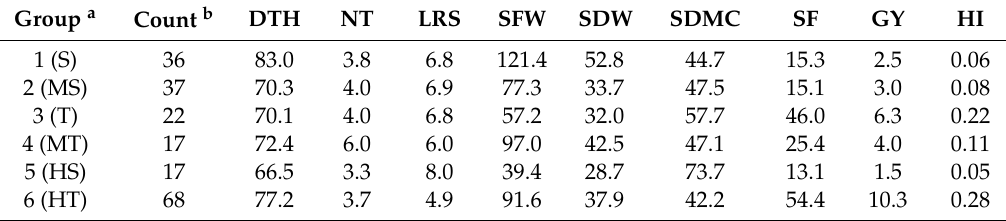
Figure 1. Principal component analysis (PCA) plot of various agronomic traits, yield, and yield-related traits in the US rice genotypes. ( a ) Scatter plot of the various rice genotypes represented in two major principal component axes. No su ffi cient clustering was observed except the California genotypes in the third quadrant. ( b ) Grouping of the variables in two principal components. PC1 represented yield-related traits and PC2 represented the agronomic traits. Table 3. Mean value of each group identified by cluster analysis for agronomic traits, yield, and yield-related traits in the US rice genotypes under drought